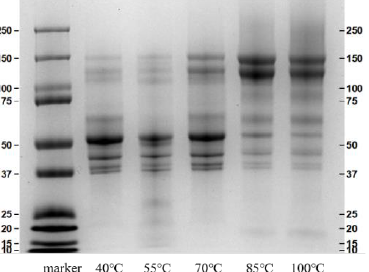
Figure 2. SDS-PAGE analysis of the EBN extracts under different temperature.